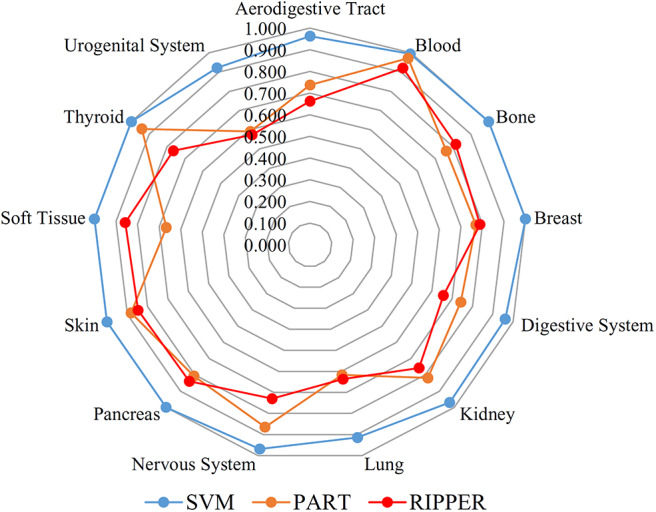
Radar chart to show the performance of the best SVM, PART and RIPPER classifiers on 13 tissues based on the feature list yielded by mRMR.